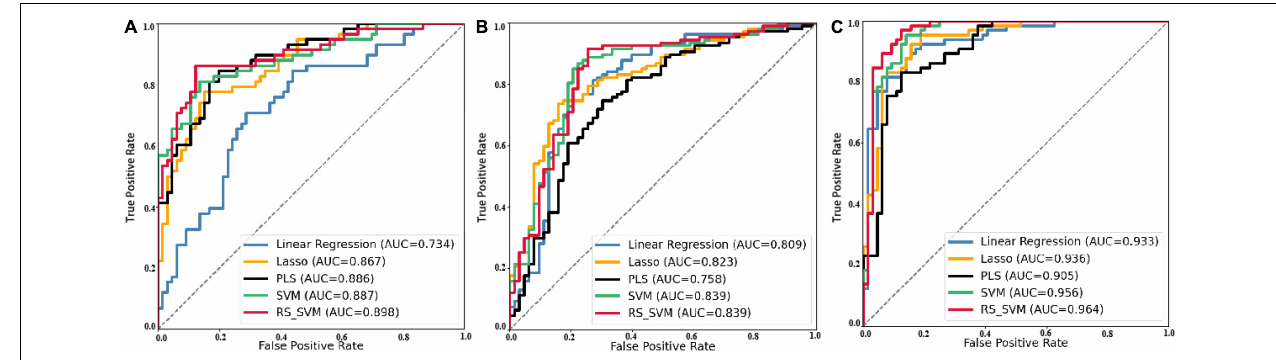
FIGURE 3 | ROC curve of five classification methods for three groups. (A) Prediction ROC of EMCI-HC group. (B) Prediction ROC of LMCI-HC group. (C) Prediction ROC of AD-HC group.